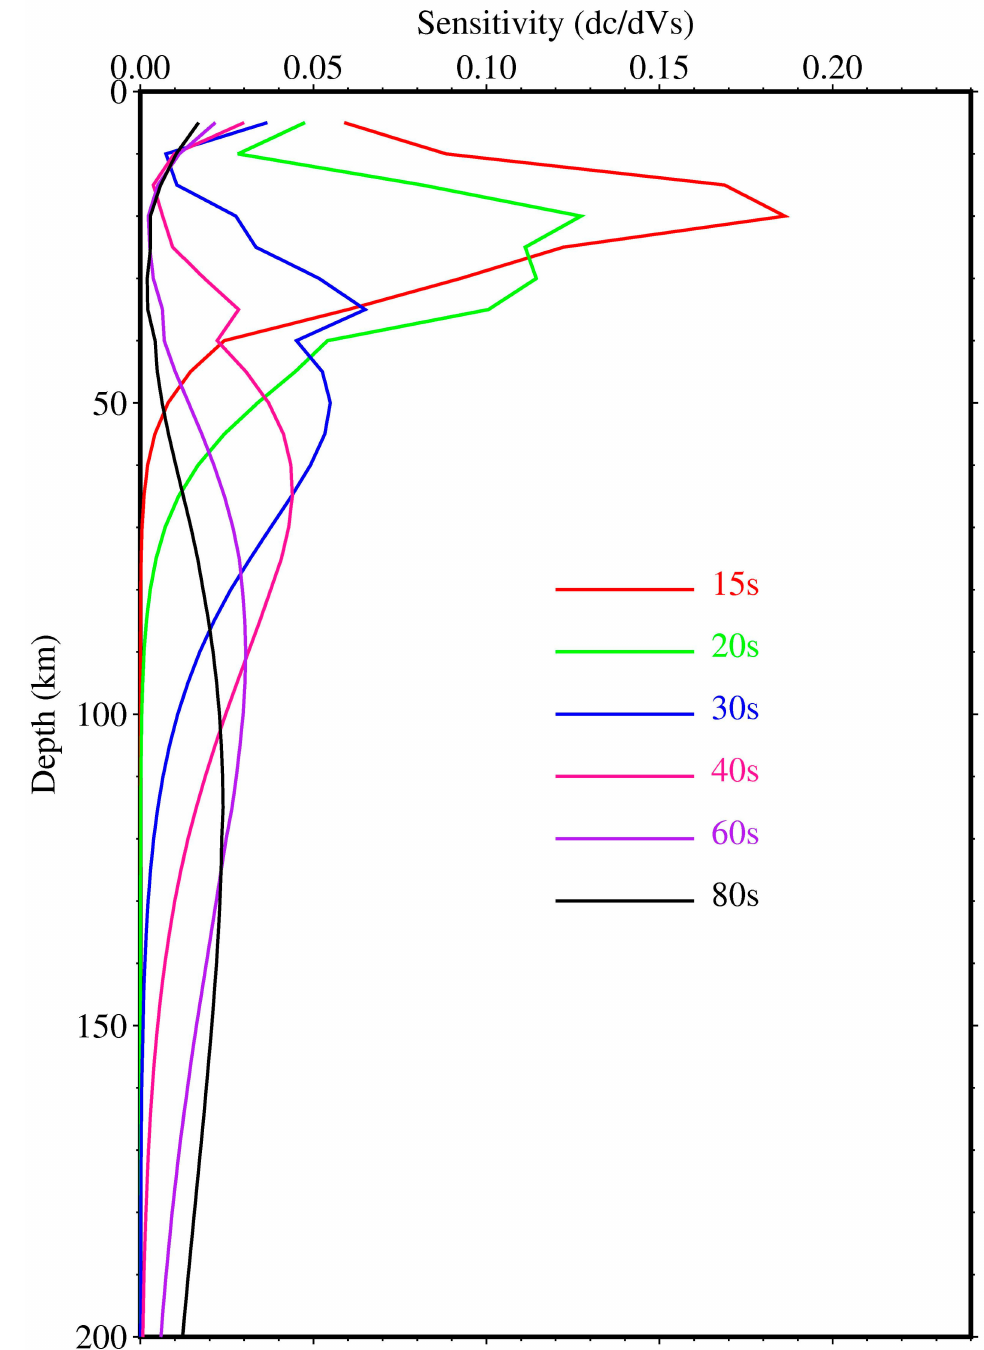
Figure 8. Sensitivity kernels of Rayleigh wave phase velocity at different